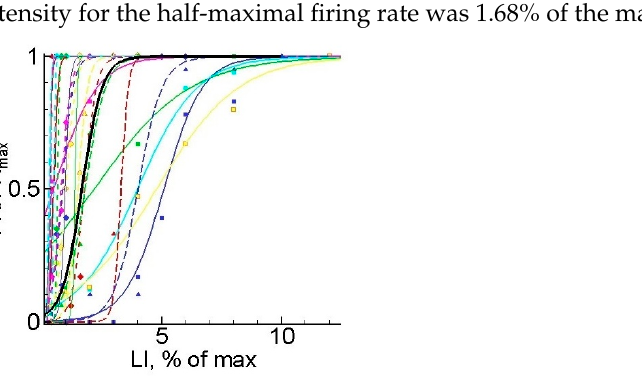
Figure A2. The dependence of the normalized firing rate ( FR ) on light intensity for individual pyramidal neurons (colored points reflect experimental data, colored curves are Boltzmann fits for each cell ( n = 15), and black curve is averaged Boltzmann fit. The averaged Boltzmann fit was calculated as FR = FR max 1 − 1 1 + e ( LI − 1.68 ) /0.42